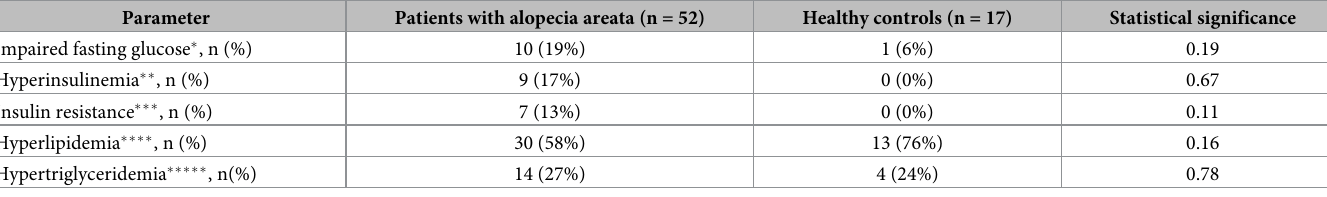
Table 3. The frequency of laboratory abnormalities in patients with alopecia areata and healthy controls. Parameter Patients with alopecia areata (n = 52) Healthy controls (n = 17) Statistical